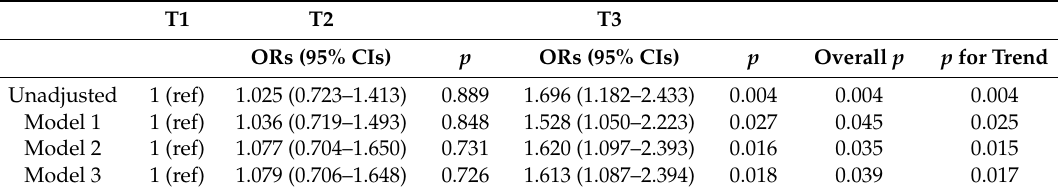
Table 2. Odds ratios with 95% confidence intervals for severe osteoarthritis according to the tertiles of log-transformed serum ALP level among osteoarthritis